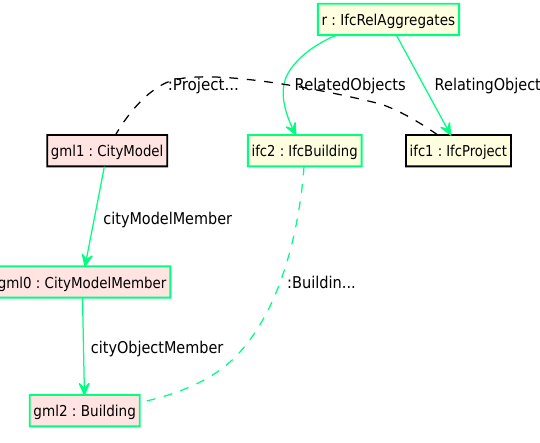
Figure 5. Concrete rule for buildings (extends aggregation, building rule, see Figures 2 and 3)